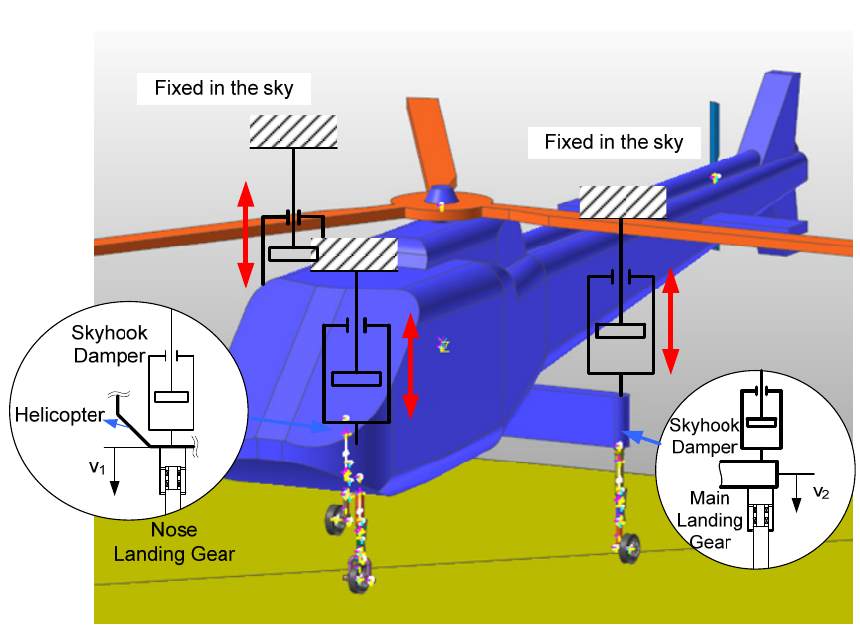
Figure 7. Concept of traditional skyhook control for the helicopter with 3 landing gears.